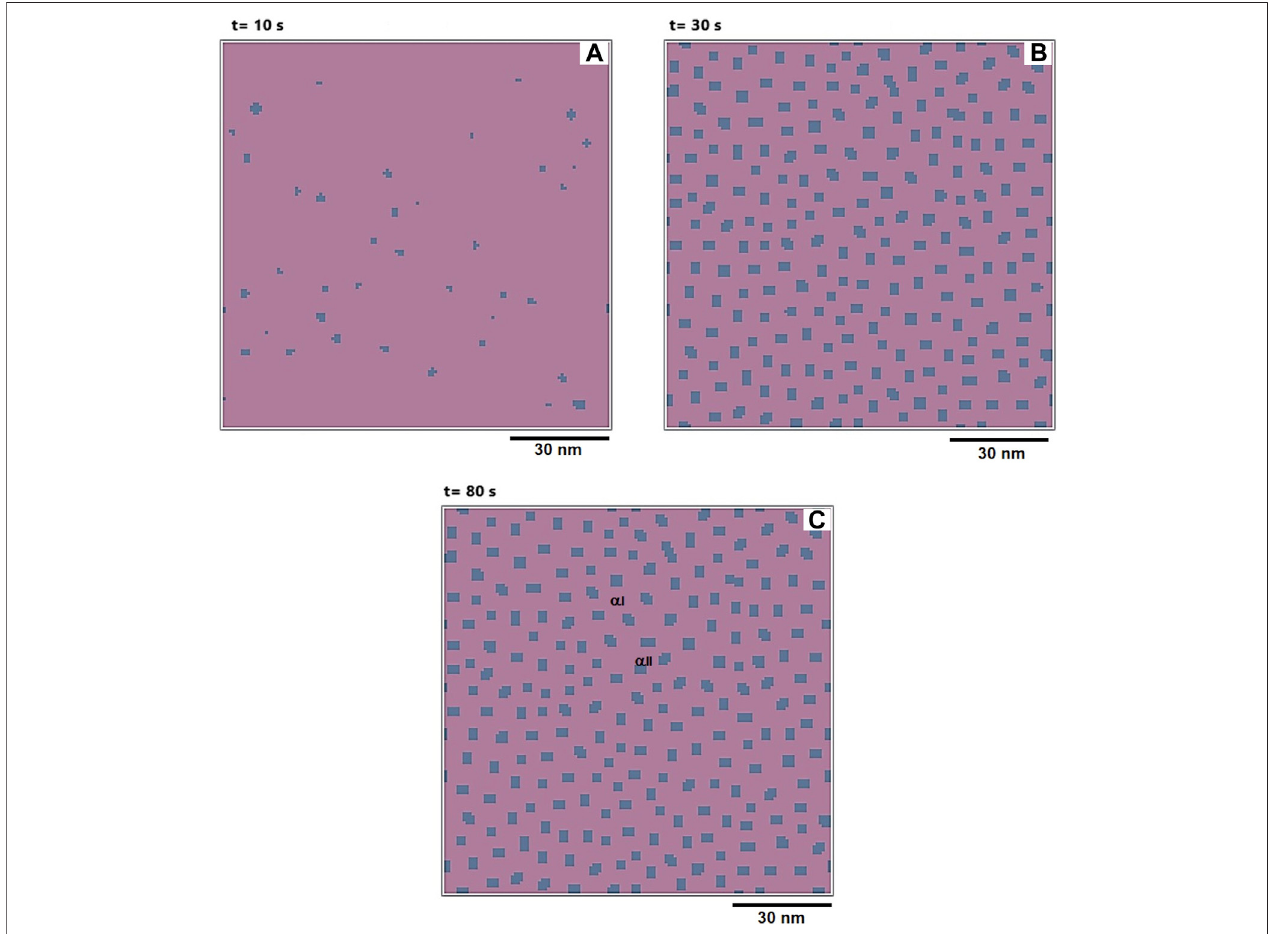
FIGURE 10 | Simulated microstructure of the A – B – C alloy for case III with X A = 0.25 , X B = 0.20 , and X c = 0.55 aged at 800 K for (A) 10 s, (B) 30 s, and (C) 80 s. s